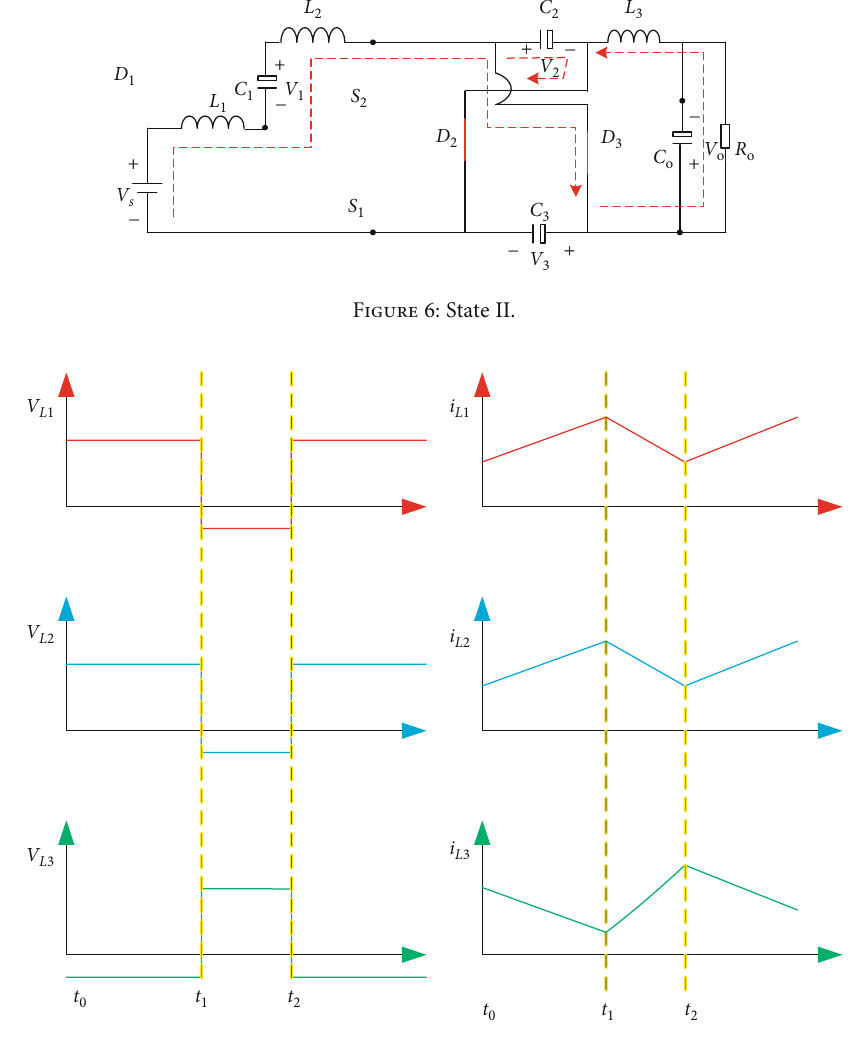
Figure 7: Steady